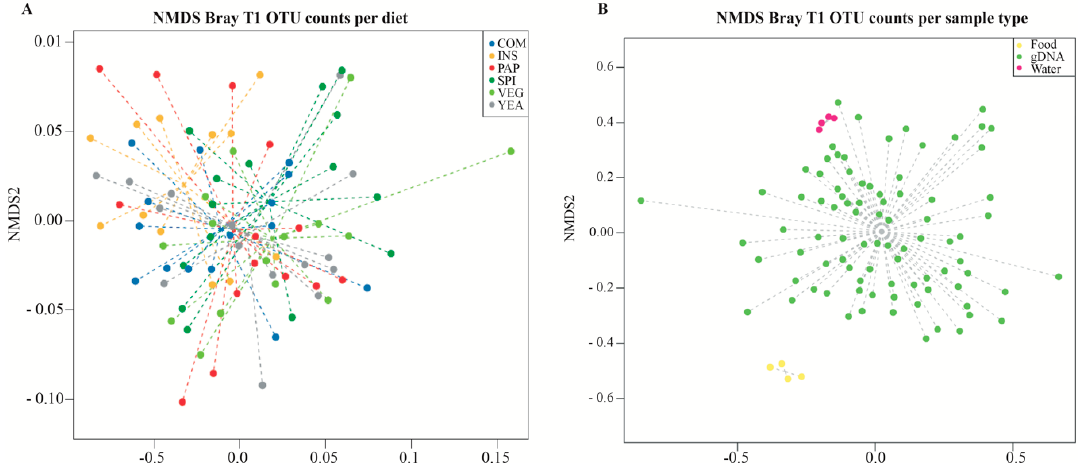
Figure 6. Non-metric multidimensional scaling plots based on Bray–Curtis dissimilarities showing the ordination between intestinal bacterial community of European sea bass fed the experimental diets ( A ) and sample type ( B ) at the end of the feeding trial (t = 93 days). Each dot represents an individual sample plot according to its microbial profile at OTU level ( n = 12 to 16 fish / diet).Top right inset: fish feed formulations used in this study: COM (conventional commercial feed control), INS (85% VEG + 15% insect), PAP (85% VEG + 15% poultry blood and feather), SPI (85% VEG + 15% cyanobacteria), VEG (100% terrestrial plants), and YEA (85% VEG + 15% yeast).